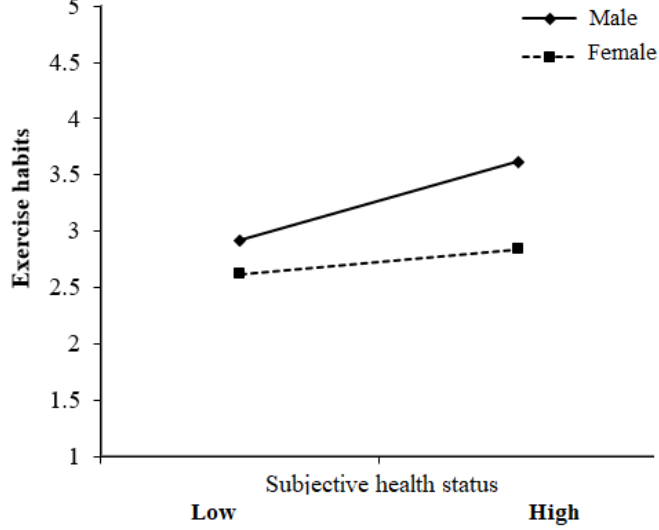
Figure 2. Influence of gender on subjective health status and exercise habits.